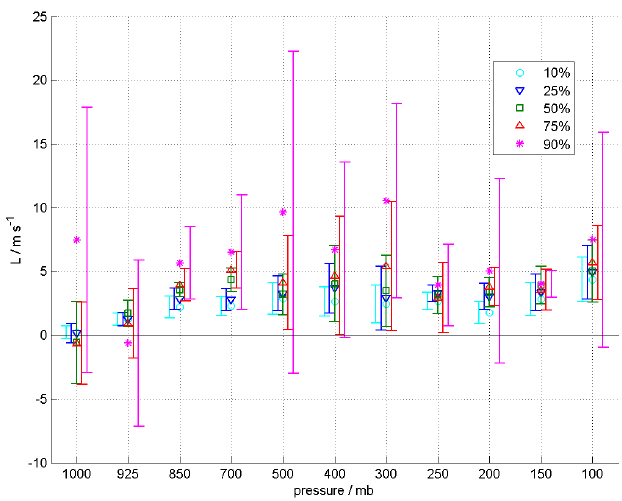
Figure 6. Results and vertical profile for the coefficient L at the five percentiles: 10%, 25%, 50%, 75%, and 90%. The error bars shown are for the 98% confidence interval.